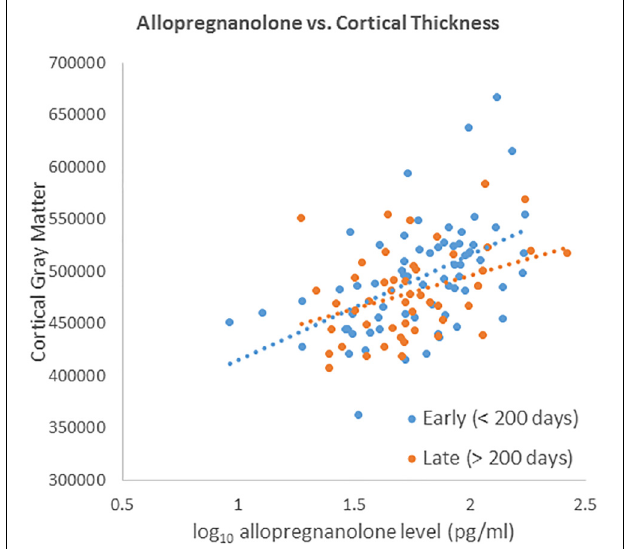
FIGURE 4 | Scatter plot of log10 transformed allopregnanolone levels ( x -axis) against cortical thickness ( y -axis) separately for the early (blue dots/line) and late subgroups (red dots/line). Fisher’s r -to- z showed no significant difference between early ( < 200) and late ( > 200) correlations ( Z = 0.901, p = 0.367).